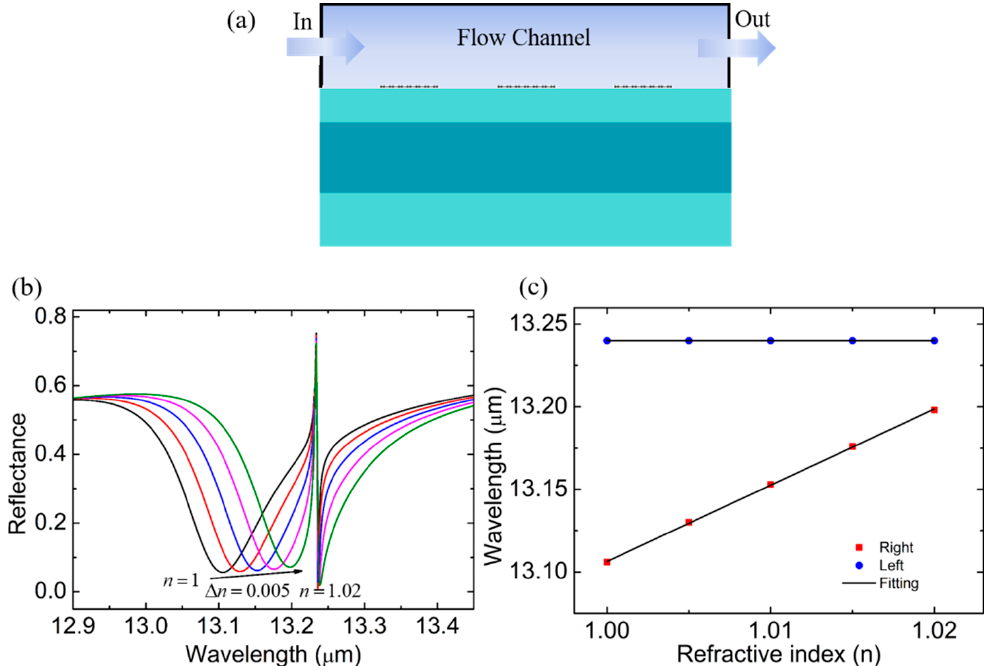
Figure 5. ( a ) Schematic diagram of the self-referencing biosensor structure. ( b ) The reflection spectrum when the RI of surrounding analyte varied from 1 to 1.02 with a step size of 0.005. ( c ) Relationship between the surrounding RI and the resonant wavelength according to Figure 5b.